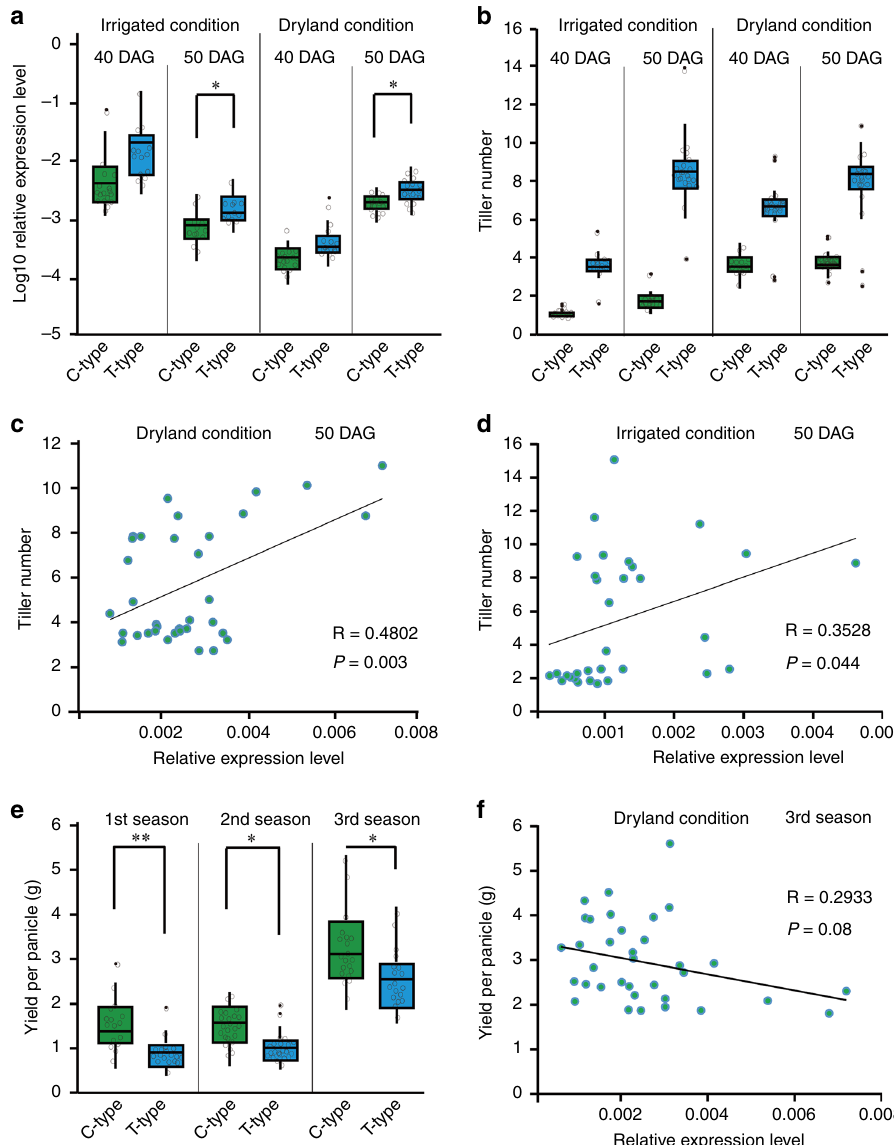
Fig. 6 SNP3 is associated with OsTb2 gene expression and phenotypes. a For the 39 cultivars, C-type cultivars have lower OsTb2 expression than the T-type at 40 DAG and 50 DAG under both irrigated and dryland conditions. b C-type is associated with fewer tillers under irrigated and dryland conditions. The expression of OsTb2 is signi fi cantly positively correlated with tiller numbers in the 39 cultivars at 50 DAG under dryland ( c ) and irrigated ( d ) conditions. e C-type cultivars have signi fi cant higher yield per panicle than T-type cultivars in three growth seasons under dryland conditions. f The expression of OsTb2 is negatively correlated with grain yield per panicle in the 39 cultivars in the 3 rd season under dryland condition. ‘ R ’ refers to Pearson product-moment correlation coef fi cient; ‘ P ’ is P -value. Student ’ s t -test analysis indicated a signi fi cant difference (* P < 0.05, ** P < 0.01). Each dot in a, b and e represents the mean value of about 8 plants and n > 15 cultivars for